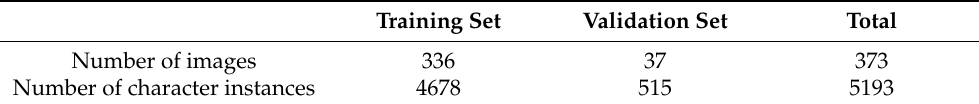
Figure 6. Example of single-character detection on a license plate. Table 6. Number of images and instances in the single-license-character detection